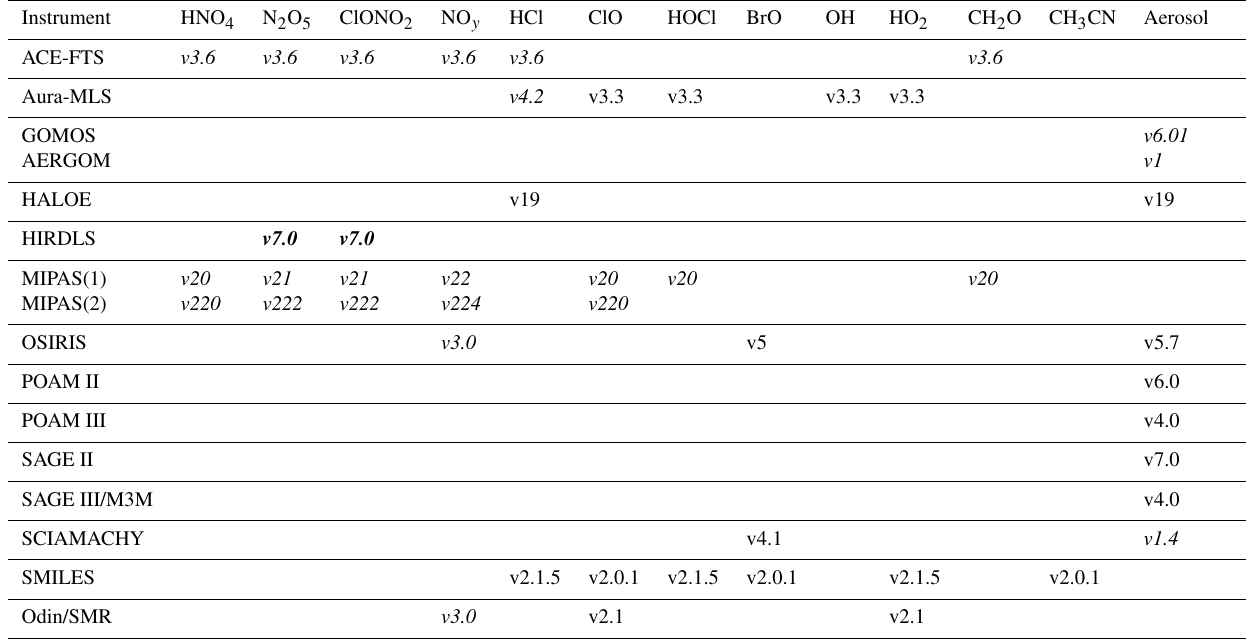
Table 2. Table 1 continued. Note that Odin NO y v3.0 is based on both OSIRIS and SMR data; hence, it has a double entry.